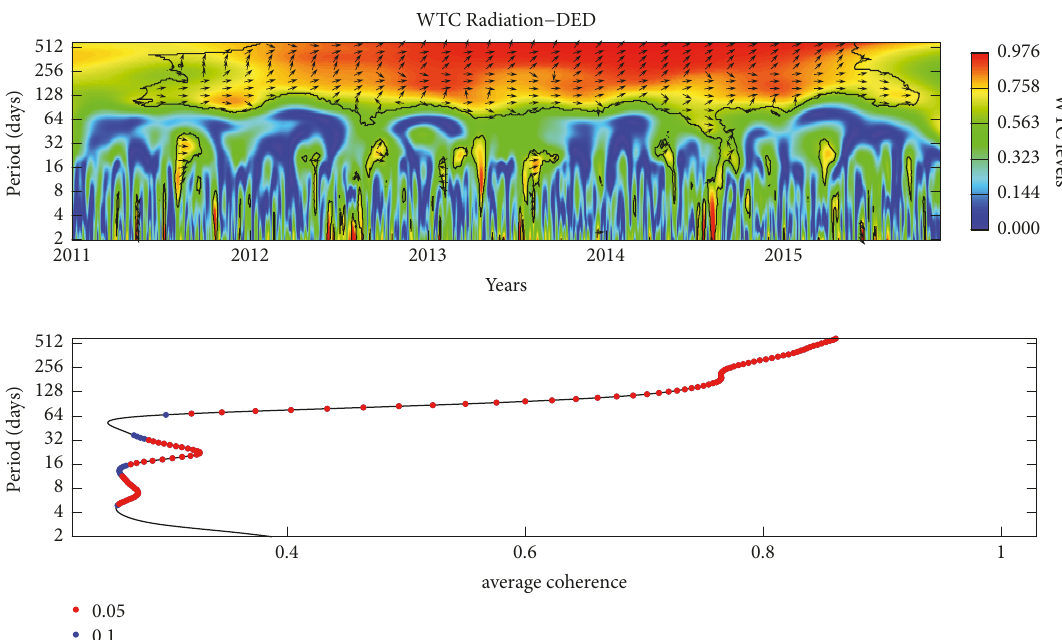
Figure 4: WTC, phase analysis, and average coherence between the solar radiation and the daily electricity demand. The black lines show area with 95% of confidence while red and blue points depict the points of 5% and 10% significance level.